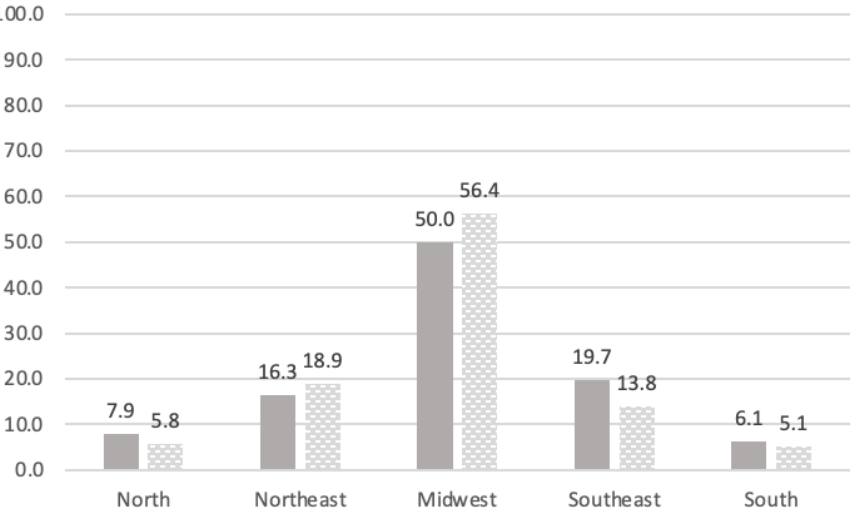
Figure 4. Percentage of respondents according to Brazilian region (Study 1, N = 386; Study 2, N = 281).